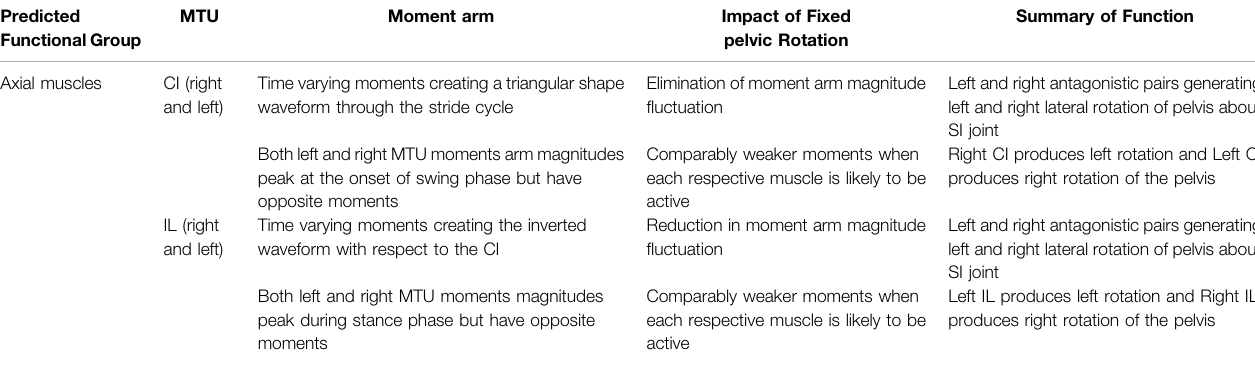
TABLE 5 | Results of walking sequence simulations RUN_ROT and RUN_FIX describing the impact of fi xing pelvic lateral rotation on the lateral rotation moment arms of the axial muscles during walking. Predicted FunctionalGroup